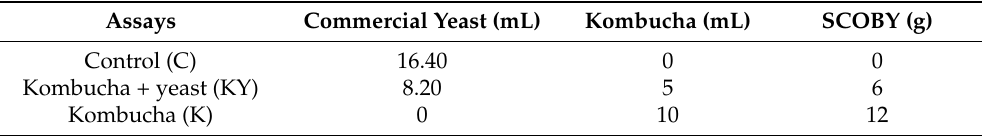
Table 1. Fermentation assays for the beer’s